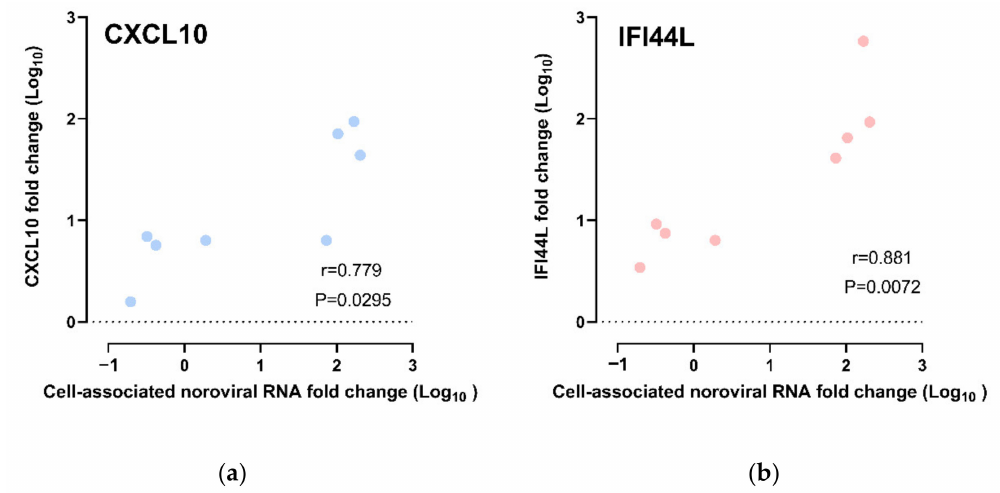
Figure 5. Correlation of gene expression fold change and cell-associated norovirus RNA fold change: All data points were included, including those from CUHK-ED-3 inoculated with CUHK-NS-1190 that showed no productive HuNoV replication, for ( a ) CXCL10 and ( b ) IFI44L.